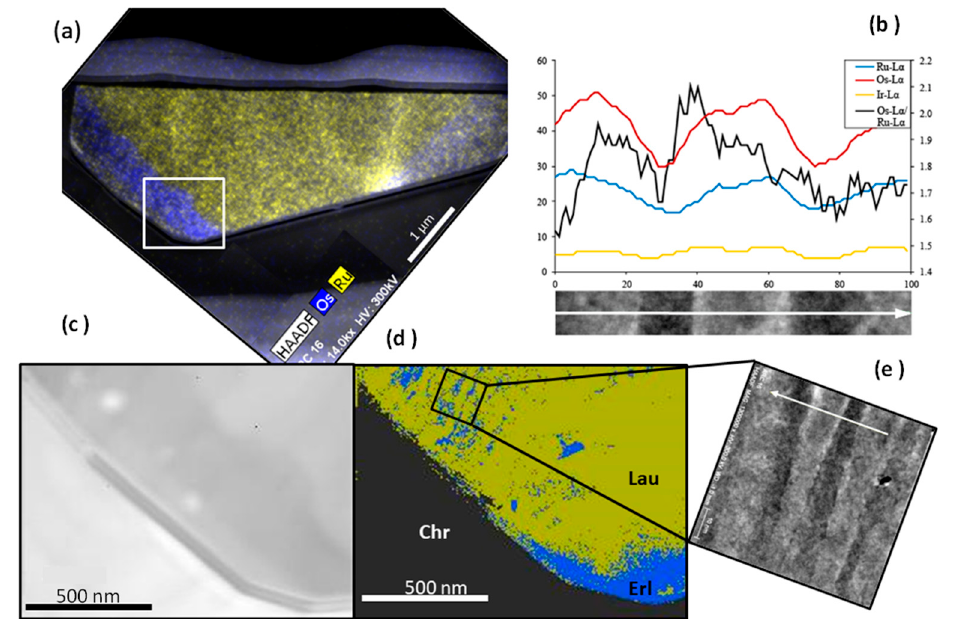
Figure 7. ( a ) TEM EDX mapping displaying Os and Ru distribution across laurite zonation, white rectangle shows the PED selected area. ( b ) Its correspondent elemental composition variability vs counts per second (cts) EDS profile displaying the Os / Ru correlation (black) with light fringes. ( c ) Virtual Bright Field (VBF) image shows the darker area enriched in Os. ( d ) Phases distribution map acquired by PED with chromite (dark grey) laurite (yellow) and erlichmanite (blue). ( e ) HAADF image of the nanoscale fringes located within the rim domain of the laurite grain with the trace of the EDS profile (white arrow).